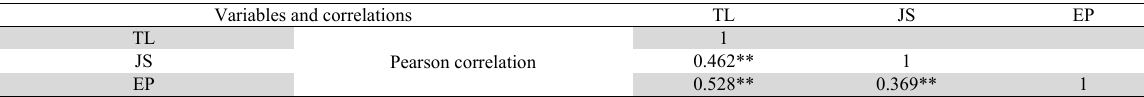
Correlation matrix Variables and correlations TL JS EP TL Pearson correlation